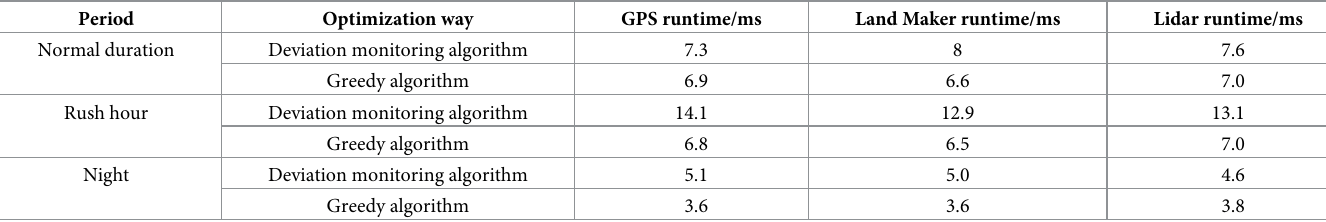
Table 4. Running time of two heuristic